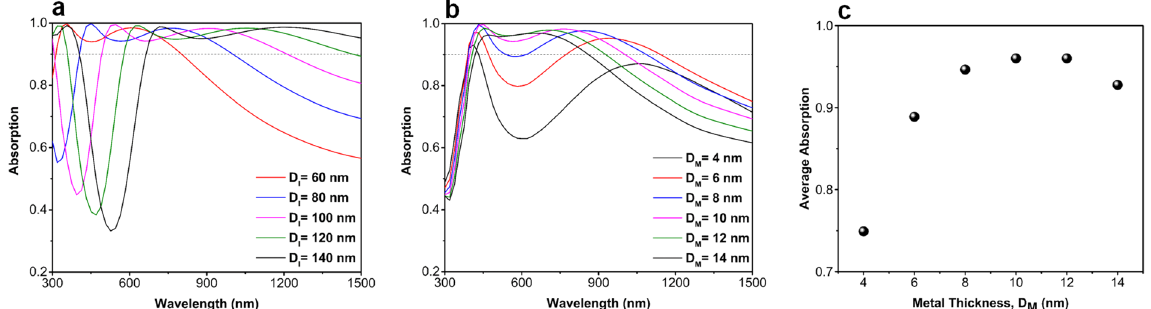
Figure 2. Absorption spectra of the fabricated MIMI stack for different ( a ) insulator layer thicknesses (D I s) and ( b ) metal layer thicknesses (D M s). Part ( c ) depicts the average absorption values for different MIMI configurations.